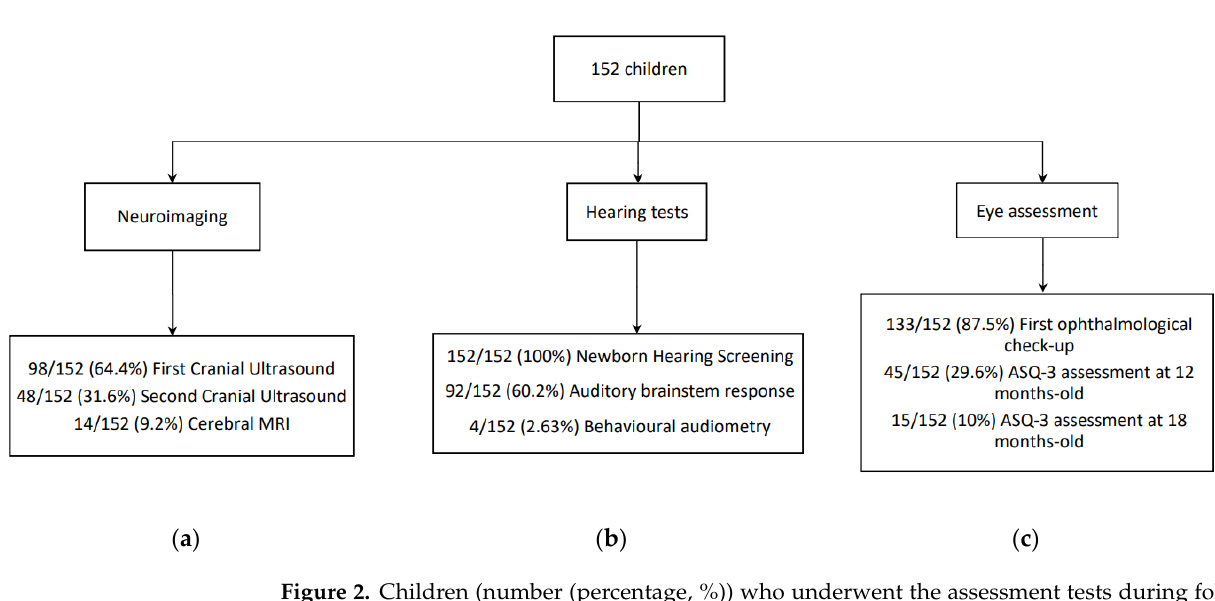
Figure 1. Individual follow-up time. Percentage (%) of children followed up to 1, 6, 12, 18, and 24 months.